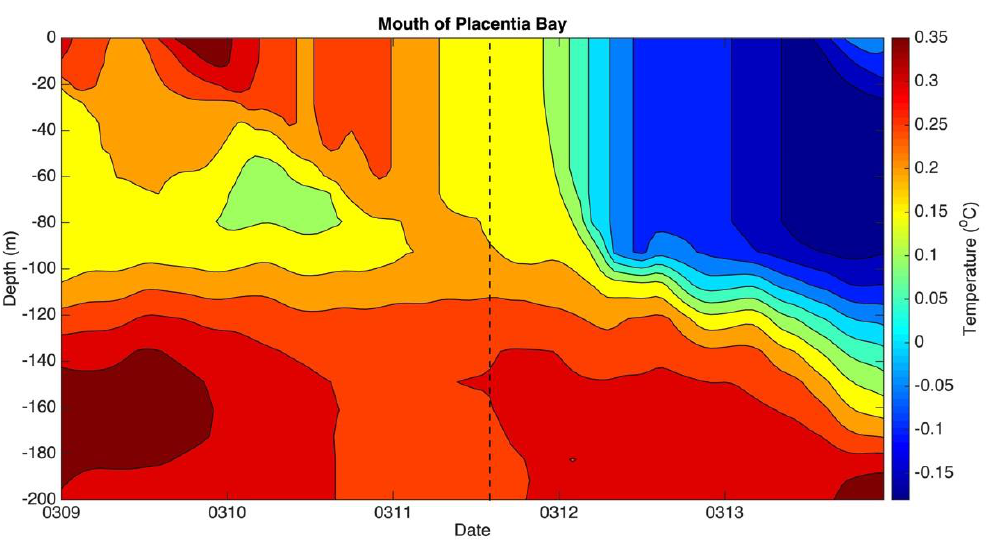
Figure 15. Temporal evolution of temperature during the winter storm. The black dashed line denotes the time when the extratropical cyclone made landfall. The contour interval is 0.05 °C.